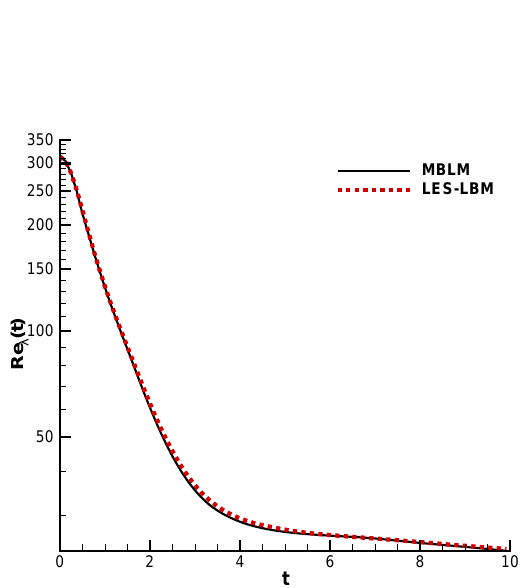
Fig. 9 Comparison of Taylor microscale, Re λ evolution on mesh 256 3